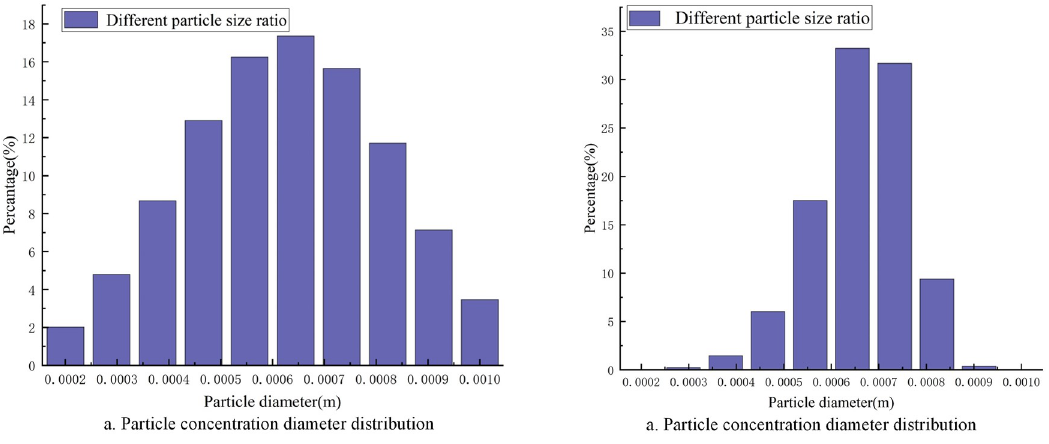
Fig 19. Particle diameter